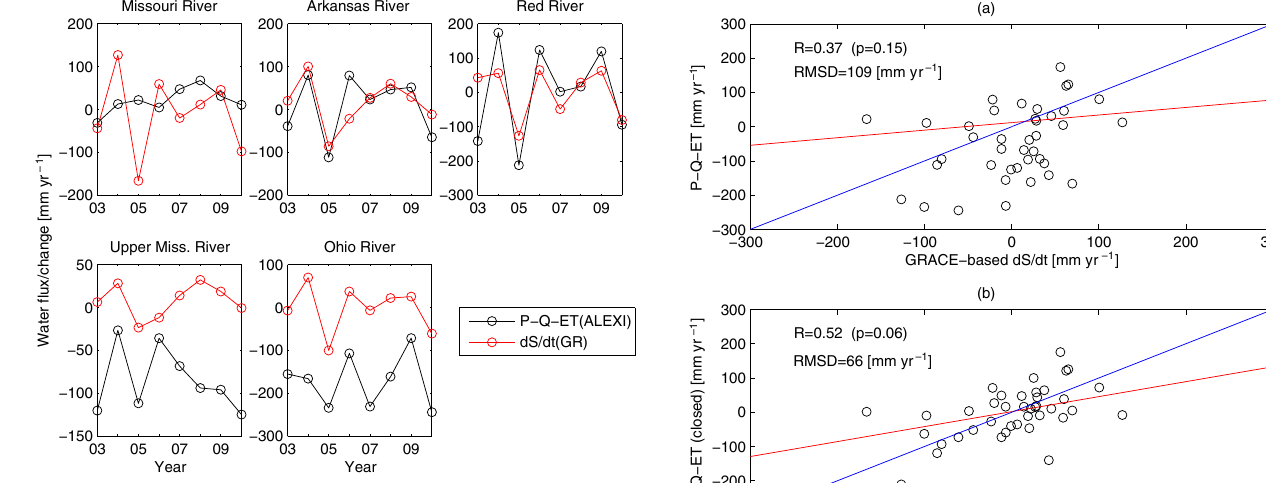
Figure 2. Annual time series of P − Q − E T (black) and gravity- based d S GR / d t (red) estimates for each of the large-scale basins listed in Table 1.